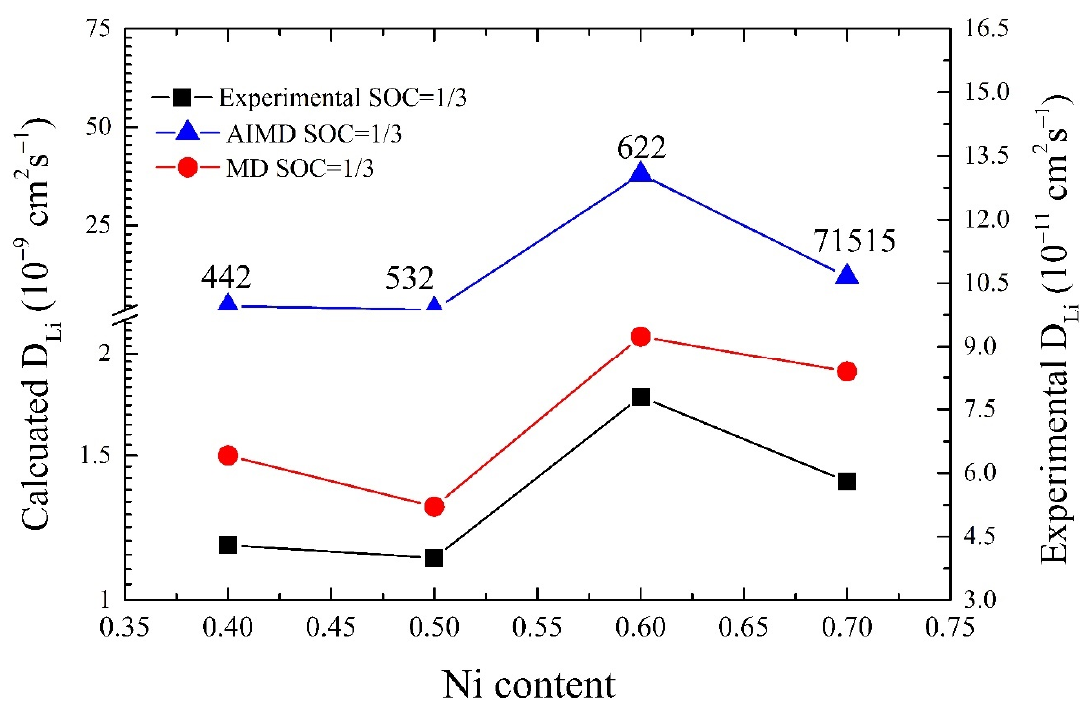
Figure 3. The diffusion coefficients of 442, 532, 622, and 71515. Black represents the experimental values measured by GITT [30]. Blue represents the values calculated obtained from AIMD simulations [30]. Red represents the calculated values by MD simulations in our work. It should be noted that all diffusion coefficients are obtained when SOC = 1/3.